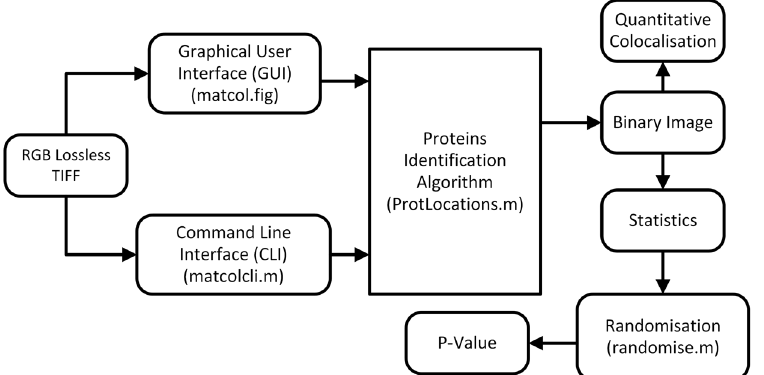
Figure 4. An overview of the MatCol software design in MATLAB. The main code file responsible for the execution of the identified component of the workflow is specified within